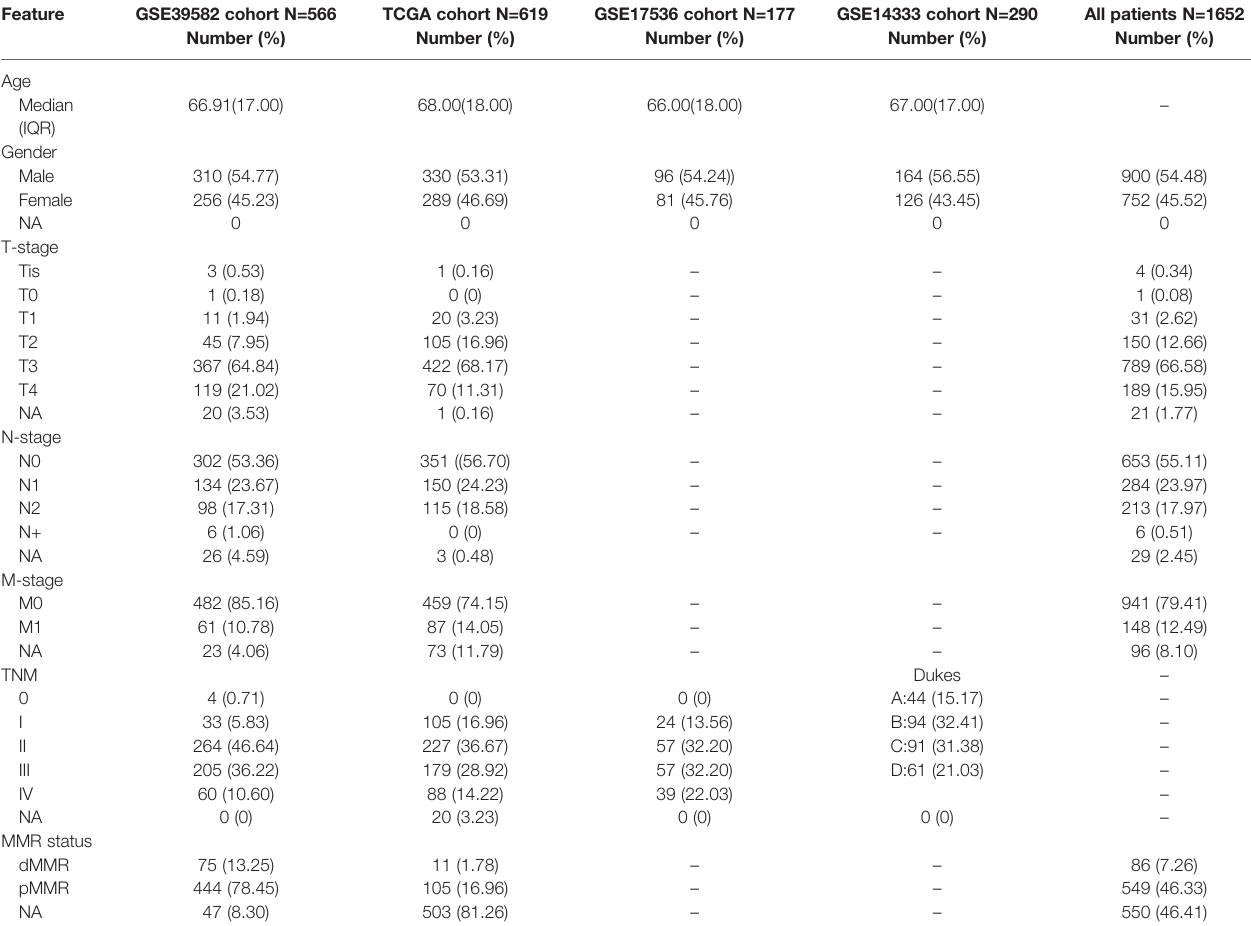
TABLE 1 | Baseline characteristics of patients in the discovery and validation cohorts.